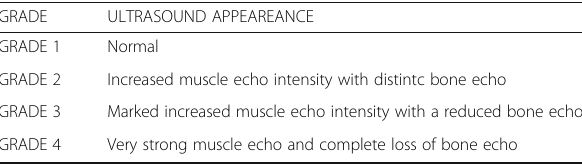
Table 1 (abstract 0220). HECKMATT SCALE: VISUAL GRADING SCALE TO CLASSIFY MUSCLE ECHO INTENSITY